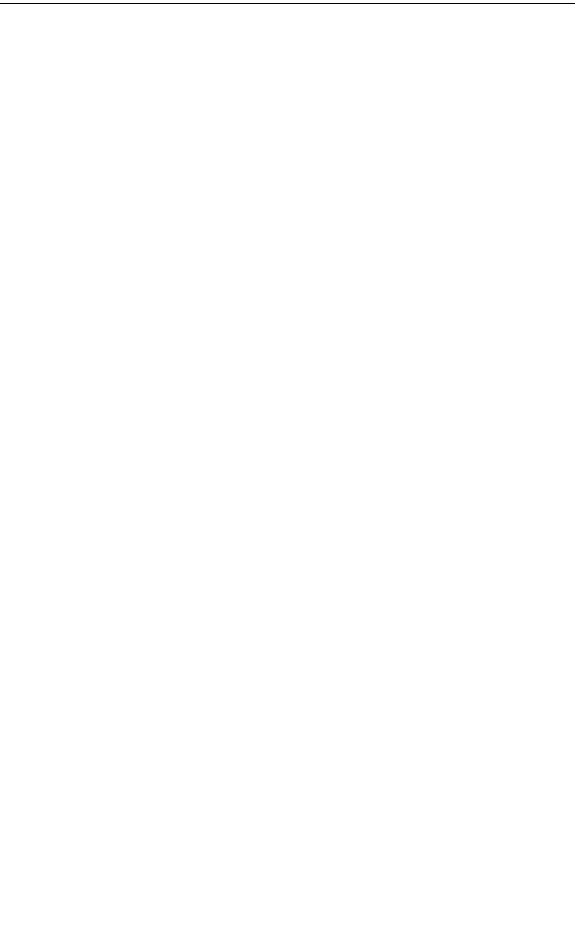
FIGUREA7 | Principal coordinates analysis (PCoA) ofThaumarchaeota rrs sequences obtained through 454 pyrosequencing of 41 samples and clone libraries generated from two depths at Station D5. Shapes indicate sample groupings: dark gray squares = deep, offshore; open triangles = near-surface, offshore; light gray circles = near-surface, inshore. The percentage of the variance explained by an axis is given in parentheses next to the axis